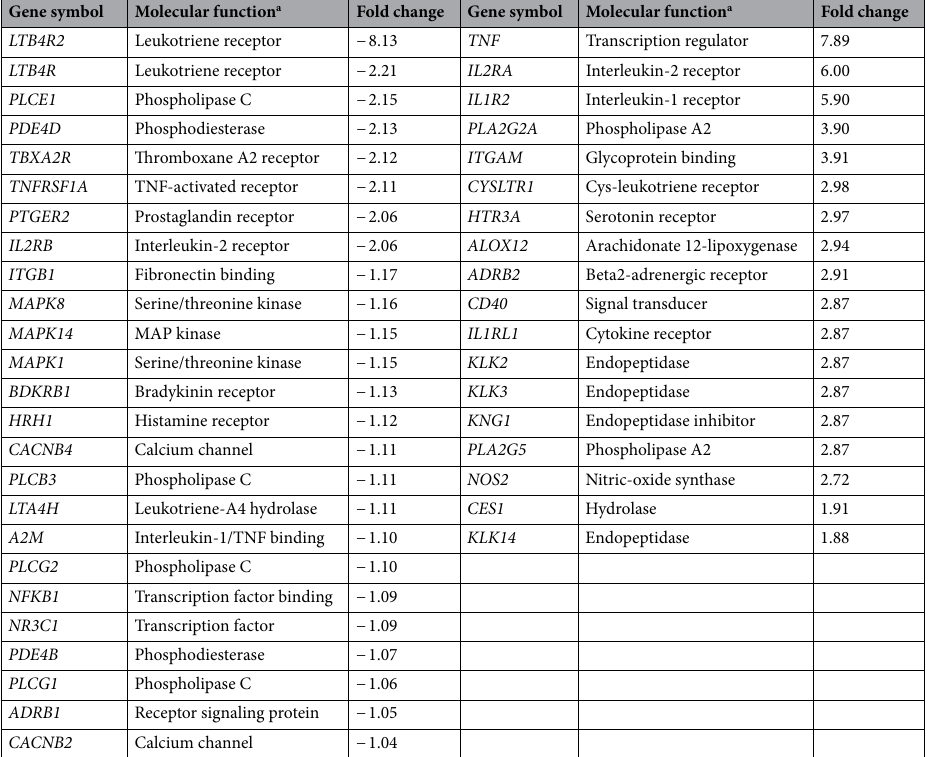
Table 1. PL modulates expression of genes involved in inflammatory processes. Differentially expressed [log2 (fold change]) genes identified by a PCR array (TaqMan Array Human Inflammation 96-well plate) in HEp-2 cells treated with PL compared to untreated cells. Genes with log2 fold change > 1.0 were considered as differentially expressed. Reproduced with permission from 95 . a According to Gene Ontology Consortium (http://geneo ntolo gy.org/) 49,50